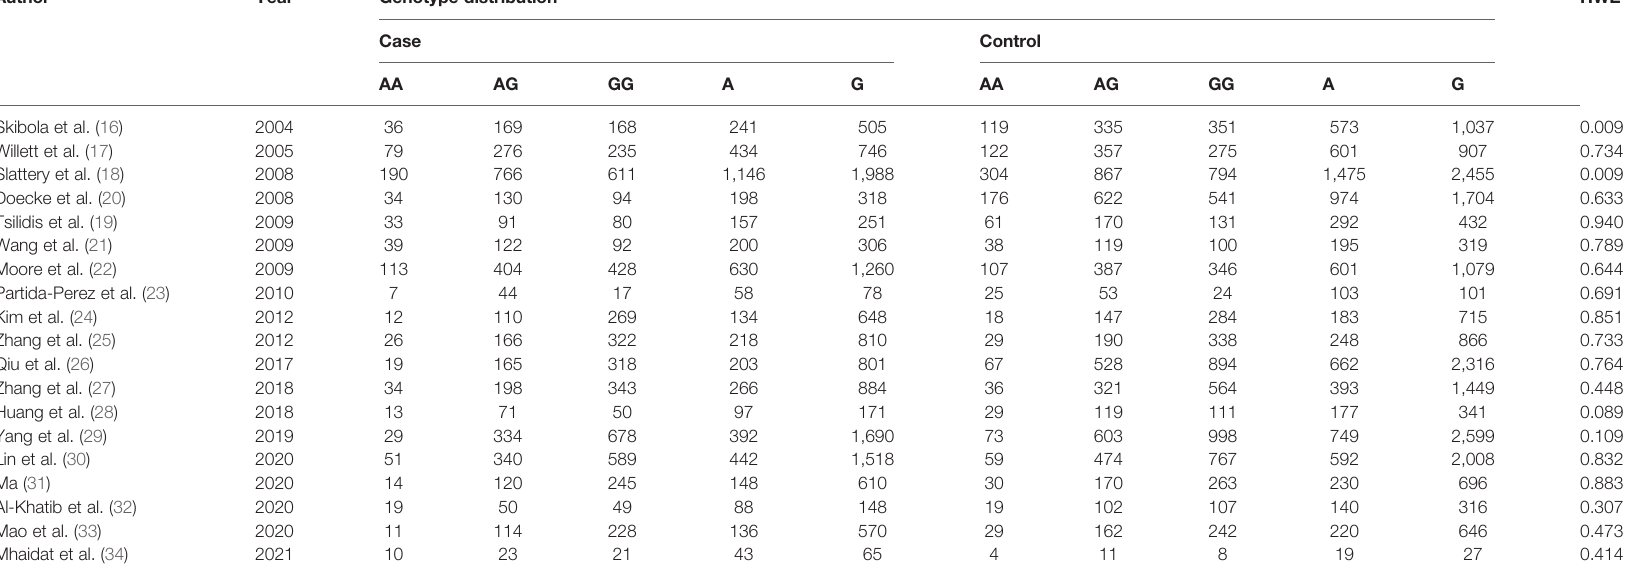
TABLE 2 | Distribution of LEP G19A polymorphism genotype and allele.